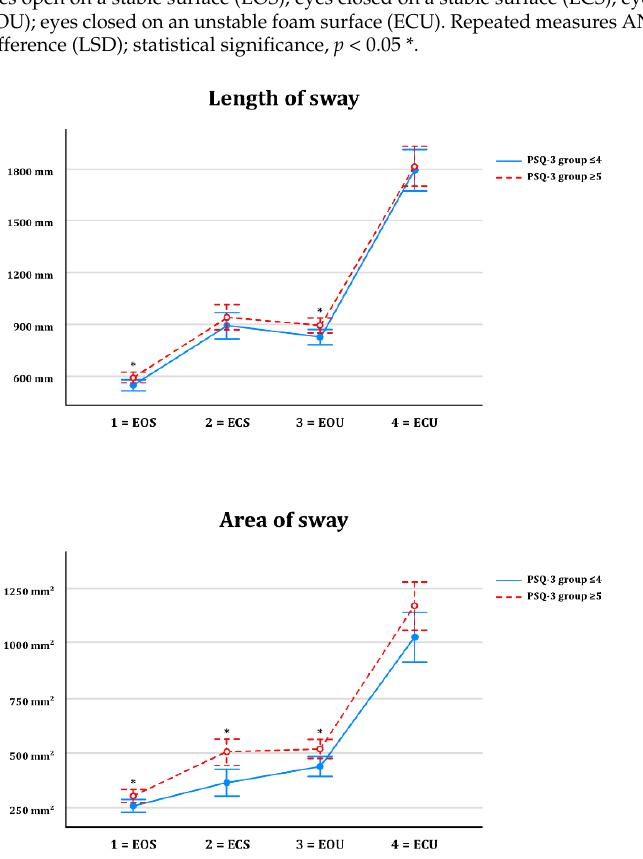
Figure 2. Postural control on PSQ-3-FI groups score ≤4 or ≥5 groups ( n = 229). 3.7. Objective Sleep Quality The parameters representing sleep quality are presented in Table 7 for the lower and higher PSQ-3-FI score groups. The average awakening length was longer in the group with higher PSQ-3-FI score (PSQ-3-FI ≥ 5) compared to the group with lower PSQ-3-FI score. The other four sleep quality parameters, total sleep time, sleep efficiency, and num- ber of awakenings lasting more than one of five minutes, were not significantly different between the groups with higher and lower PSQ-3 scores. Table 7. Sleep quality measures based on actigraphy for the PSQ-3-FI score ≤ 4 and ≥ 5 groups (n = 40).